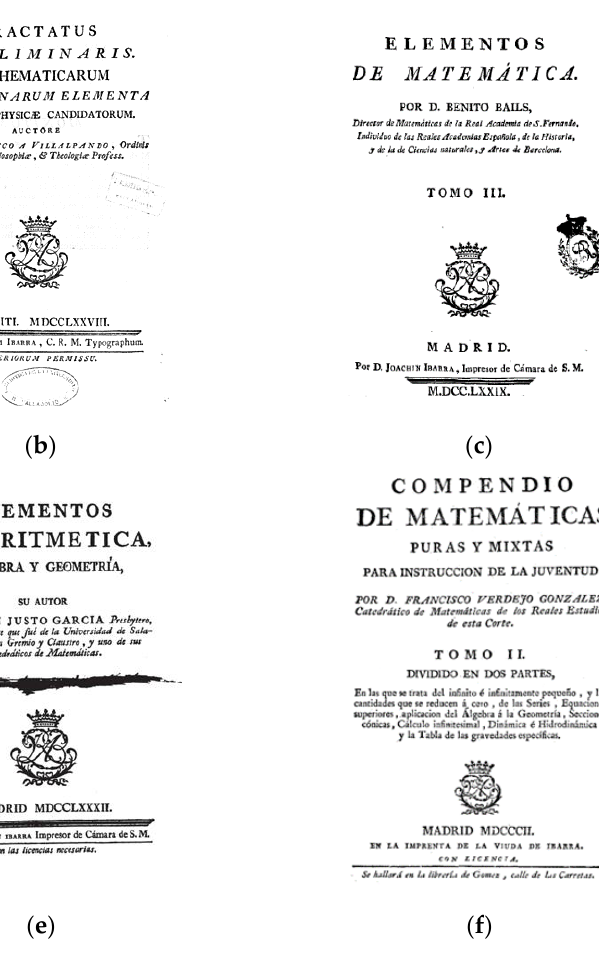
Figure 1. Covers of analysed textbooks ( a ) Padilla and Arcos [54]; ( b ) Villalpando [55]; ( c ) Bails [56]; ( d ) Juan Justo García [57]; ( e ) Giannini [58]; and ( f ) Verdejo [59]. Table 1. Textbooks analysed and institutions to which they were directed [49].